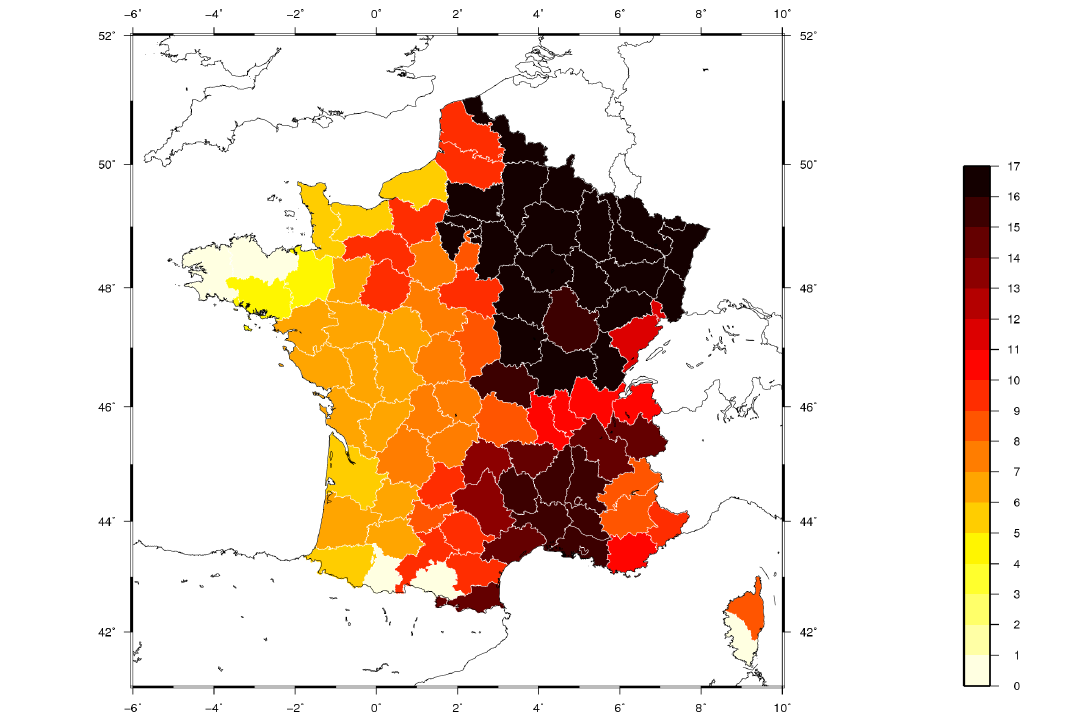
Figure 8. Duration (number of days) of the 2018 heat wave county per county.